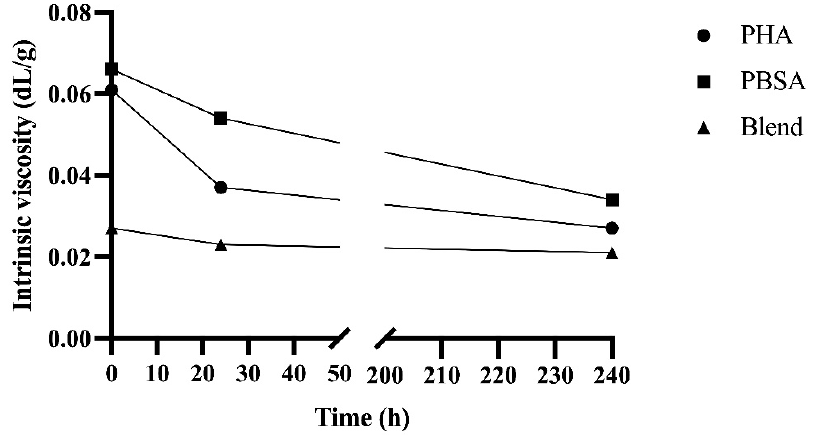
Figure 5. Intrinsic viscosities of PHA, PBSA, and Blend treatments after fermentation in rumen fluid for 0, 24, and 240 h in F57 bags.